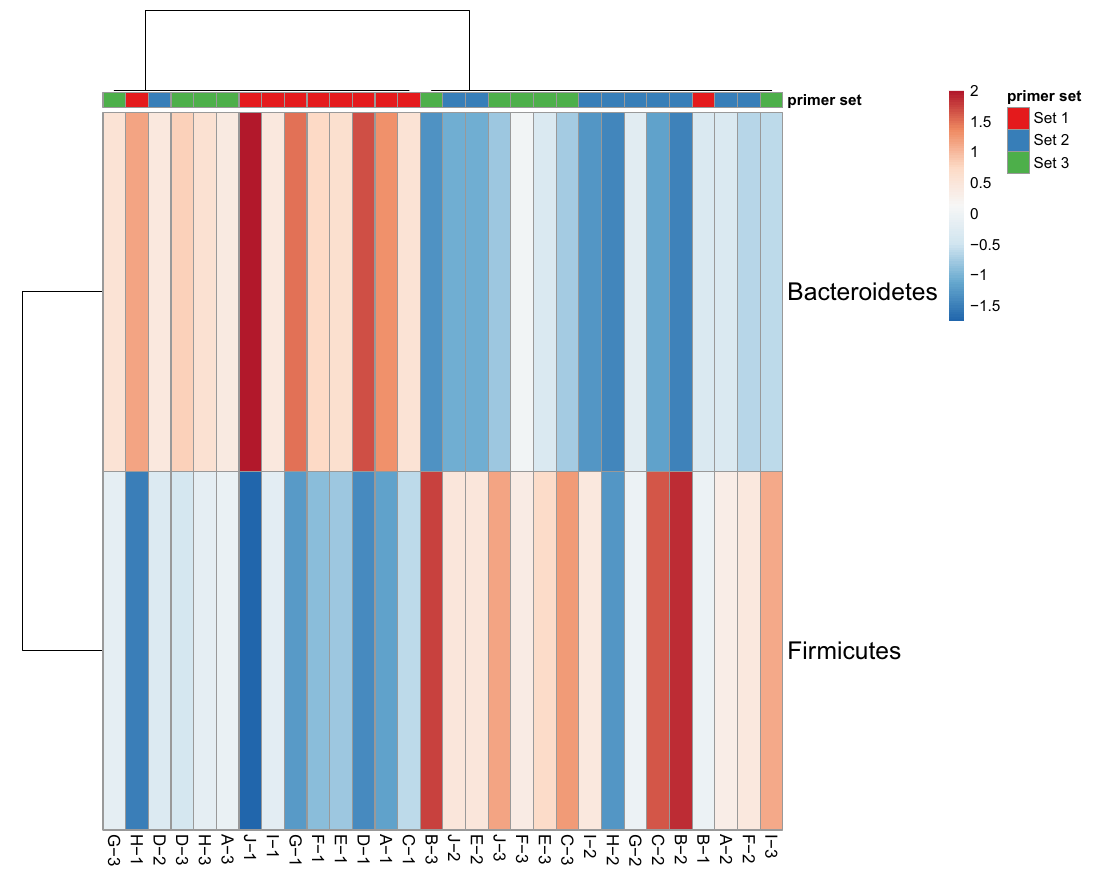
Figure 3. Firmicutes to Bacteroidetes ratio in faecal samples of ASD patients visualized by heatmap. Increased relative abundance of Bacteroidetes compared to Firmicutes in samples in that for amplification of 16S rRNA primer set#1 was used, compared to samples processed with primer set#2 and set#3.